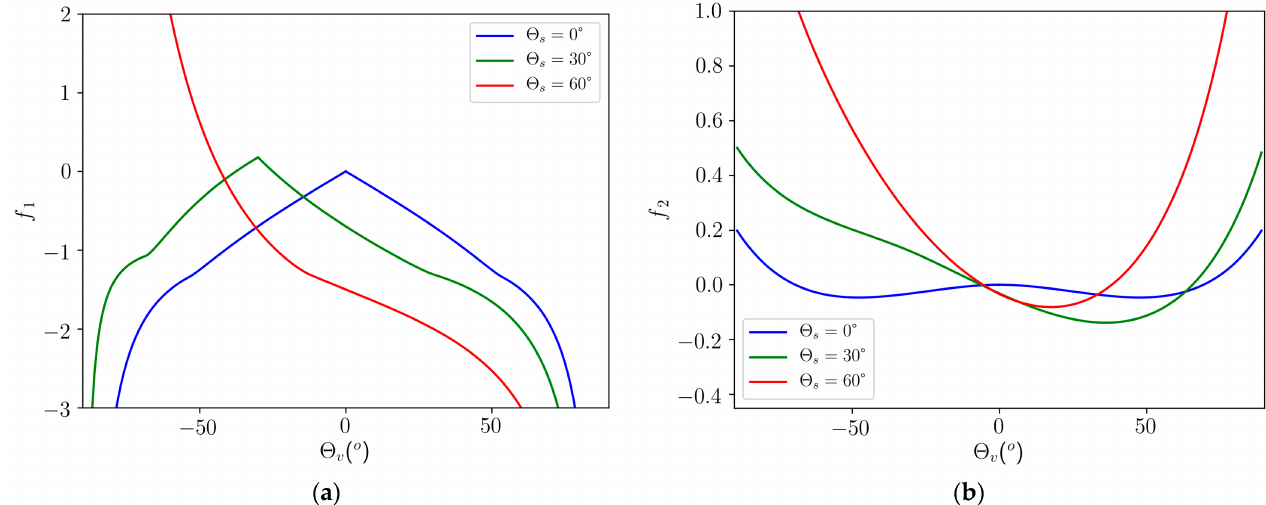
Figure 2. Angular dependence of the geometric ( a ) and volumetric ( b ) scattering kernels of the RTLS (RossThick-LiSparse- Reciprocal) model. Both graphs correspond to the principal plane (i.e., conditions with a relative azimuth equal to 0 ◦ or 180 ◦ ). Negative zenith angle values correspond to the back-scattering direction (relative azimuth angle = 0 ◦ ) and positive zenith angle values to the forward scattering direction (180 ◦ ).